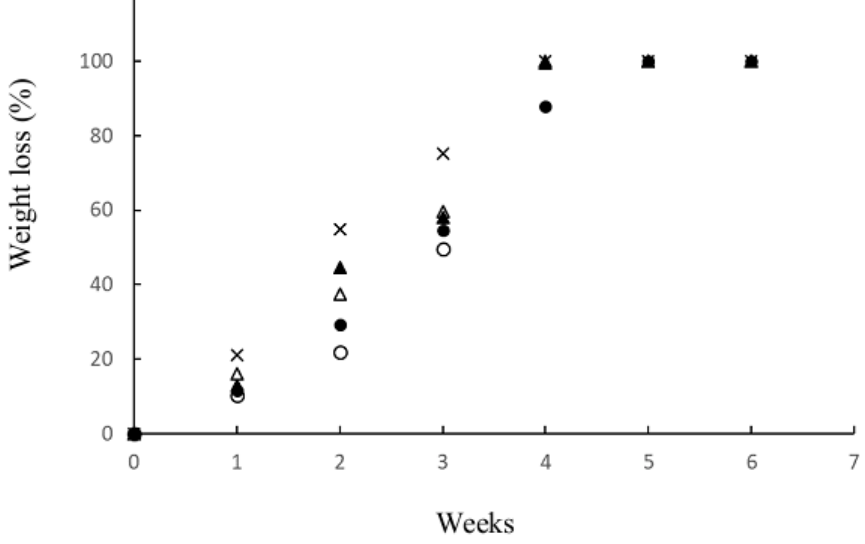
Figure 11. Biodegradability of films in soil after 0–6 weeks. (BC = × ; 0.5 NR–BC50 = white triangle; 2.5 NR–BC50 = white circle; 5 NR–BC50 = black circle; 10 NR–BC50 = black triangle).